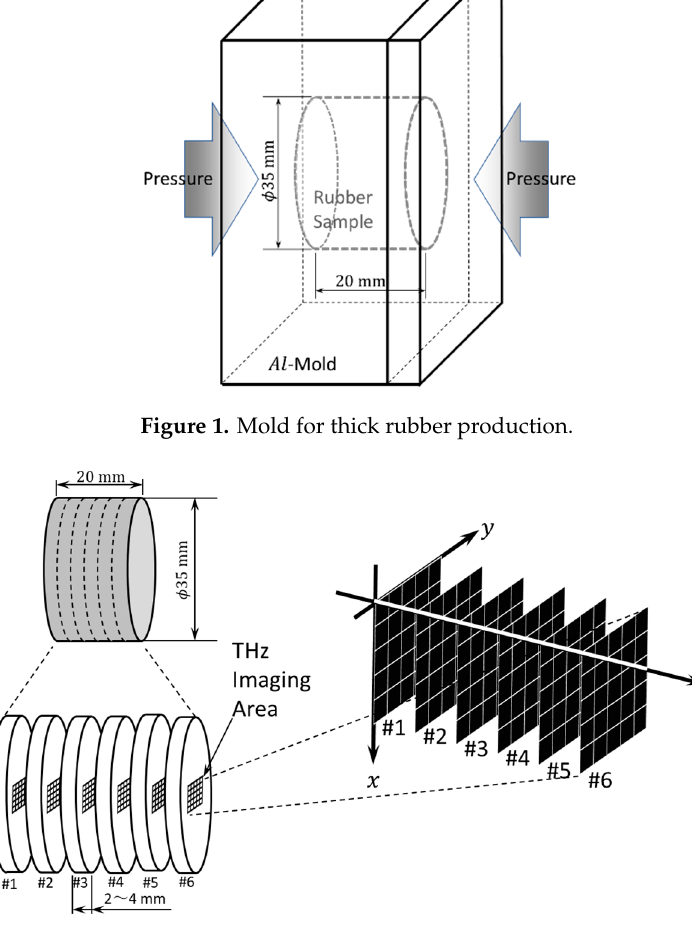
Figure 2. Sample preparation and measured areas for THz-TDS evaluation of thick rubber.